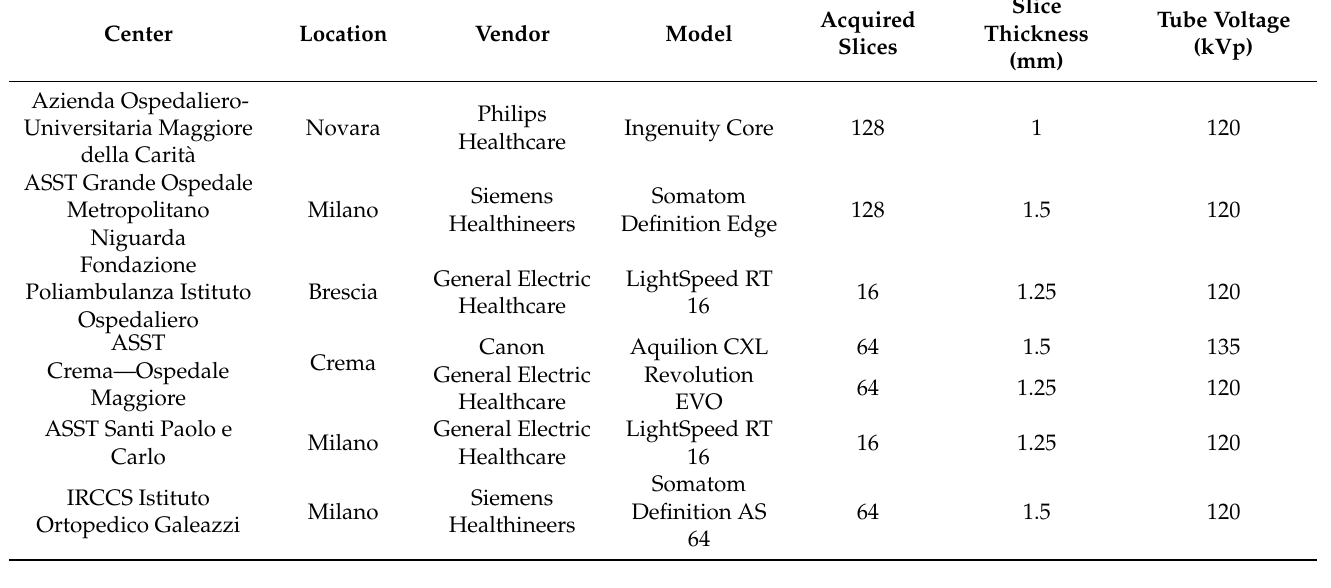
Table 1. Center-specific technical characteristics of the CT scanners and acquisition parameters.